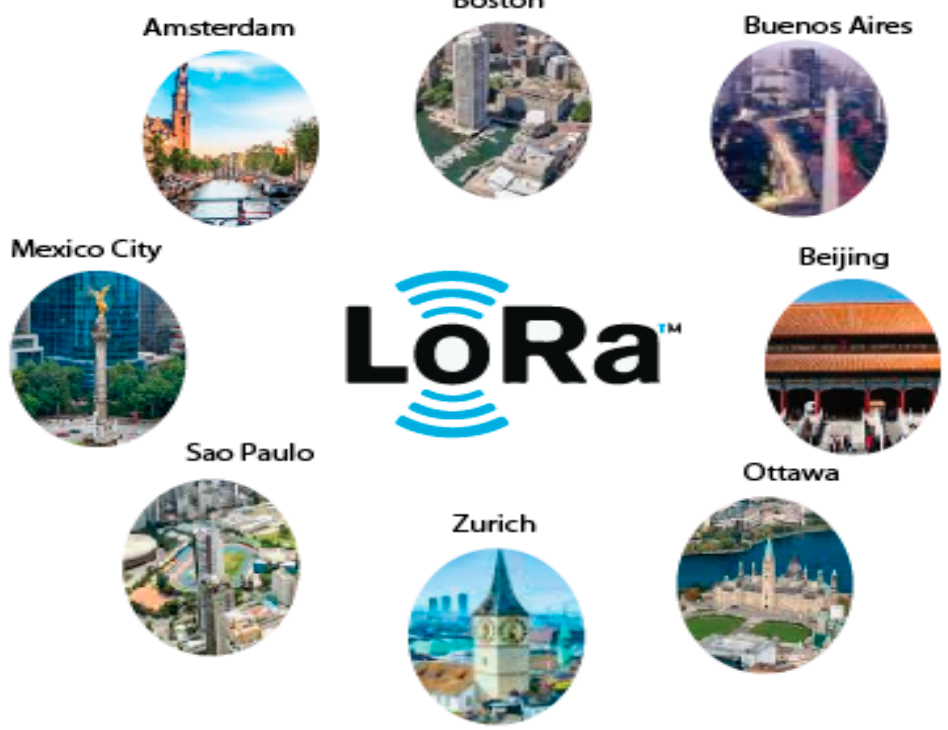
Figure 17. Smart cities according to ITU in 2019 [79].